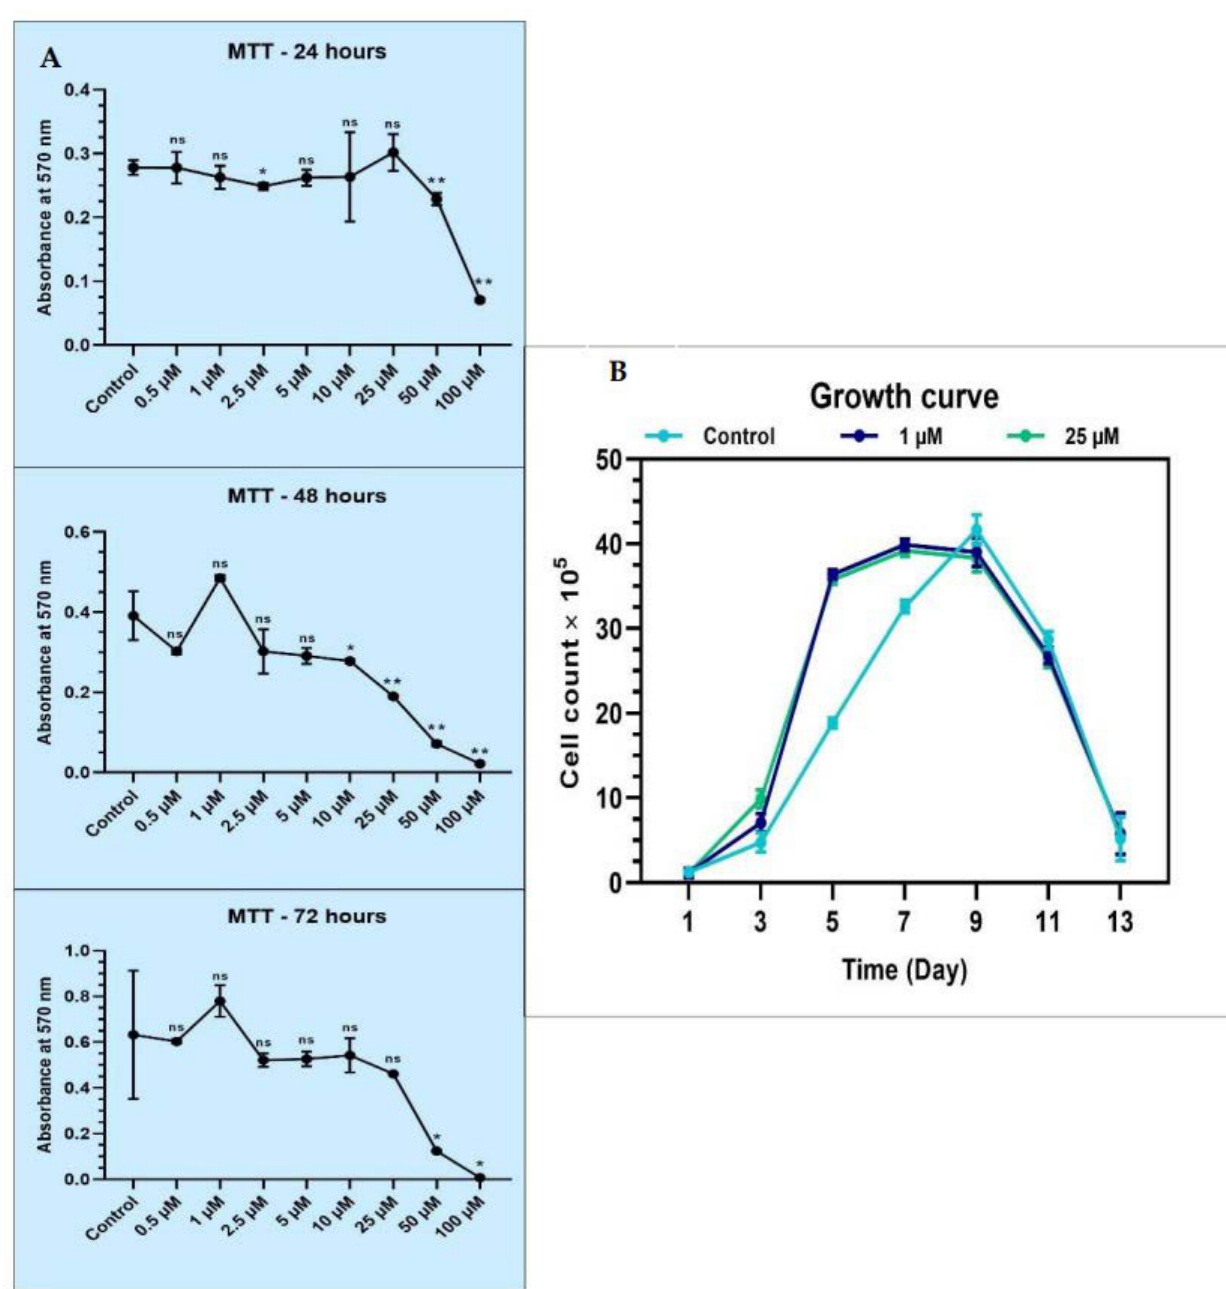
Figure 2. ( A ) MTT assay for comparative cell viability of DPSCs treated with various concentrations of melatonin and comparative population doubling the time of DPSCs treated with low (1 µ M) and high (25 µ M) concentrations of melatonin. ns, not significant; * p < 0.05 and ** p < 0.01; ( B ) proliferative ability of DPSCs in the absence (control) and presence of 1 µ M and 25 µ M melatonin for 13